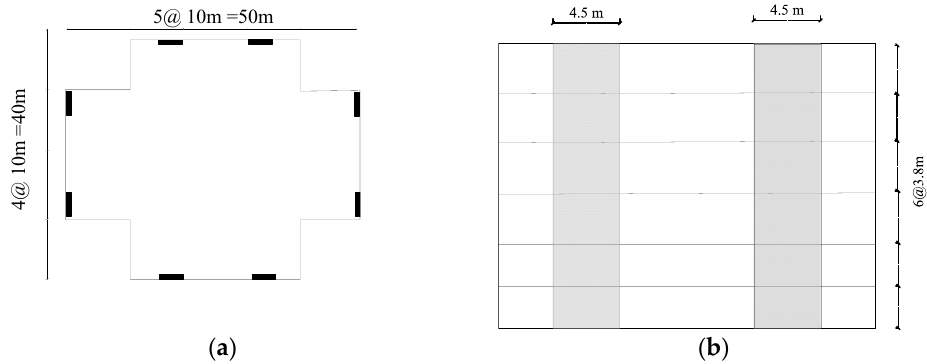
Figure 12. The steel shear wall application and location (2012) ( a ) The plan view ( b ) The elevation view.